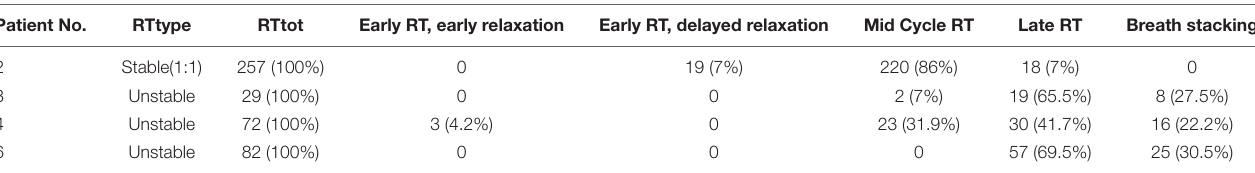
TABLE 3A | Phenotypes of reverse trigger. Patient